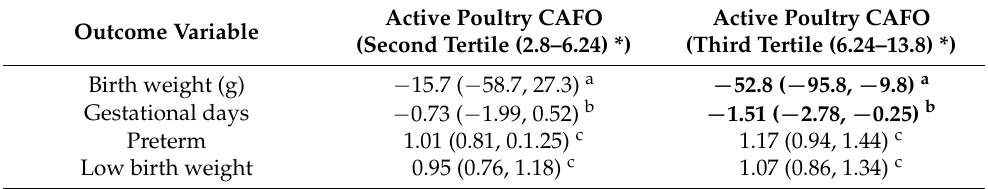
Table 2. Associations between birth outcomes and proximity to poultry CAFOs quantified by using IDW model. In parentheses, 95% confidence intervals are provided